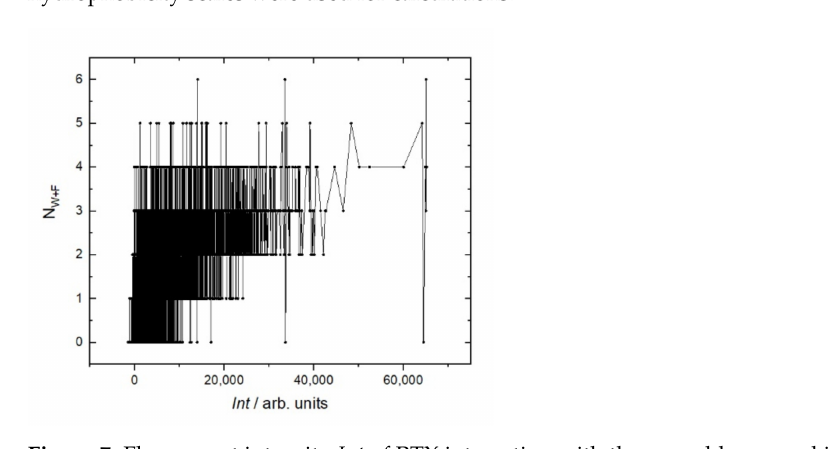
Figure 7. Fluorescent intensity Int of RTX interaction with the resemblance-ranking peptide library versus the number of sum of hydrophobic amino acids W and F of the corresponding